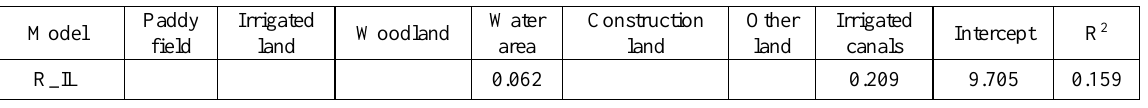
Table 4. Association between SOC content and land use percentages for samples of irrigated lands R_IL: stepwise regression based on samples of irrigated lands; Void coefficients denote not significant (p>0.05); the regressions based on samples of paddy fields and woodlands did not pass through F test (p>0.05).